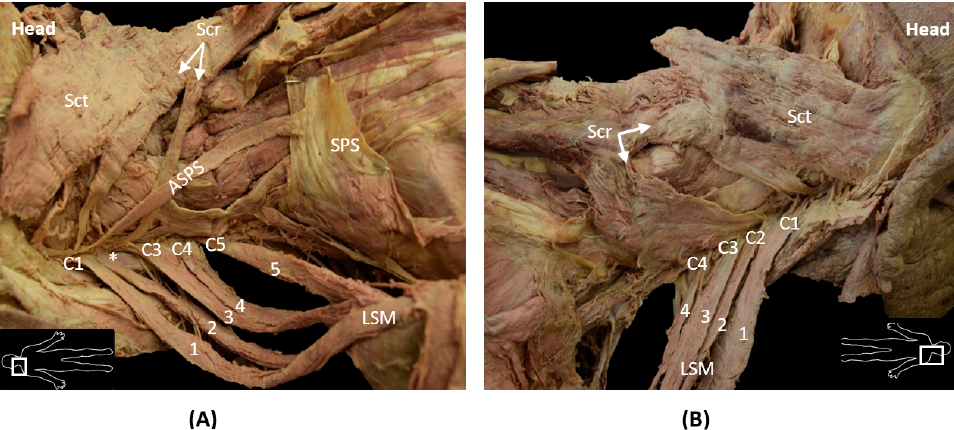
Figure 3. A and 3B: Bilateral Asymmetry. ( A ) Illustrates left-sided variations in LSM anatomy. Differences in cervical origins of the five muscular slips of the left LSM. Shared vertebral origin of LSM upper slips 1 and 2, distal bifurcation of middle slip producing slips 3 and 4 with different cervical origins, no muscular slip originating from C2 (*). ( B ) Illustrates common anatomy of right sided LSM. Four muscular slips of the LSM with no variation in cervical origins. Accessory Serratus Posterior Superior (ASPS) Muscle; Atlas transverse process (C1); Transverse processes of cervical vertebrae 2–5 (C2-5 ) Spinous process of cervical vertebra 7(C7); Levator Scapulae Muscle ( LSM ) which includes the Levator Scapulae Muscle Slips 1–5; Serratus Posterior Superior (SPS ) Muscle; Splenius capitis (Sct ) Muscle; Splenius Cervicis (Scr ) Muscle.